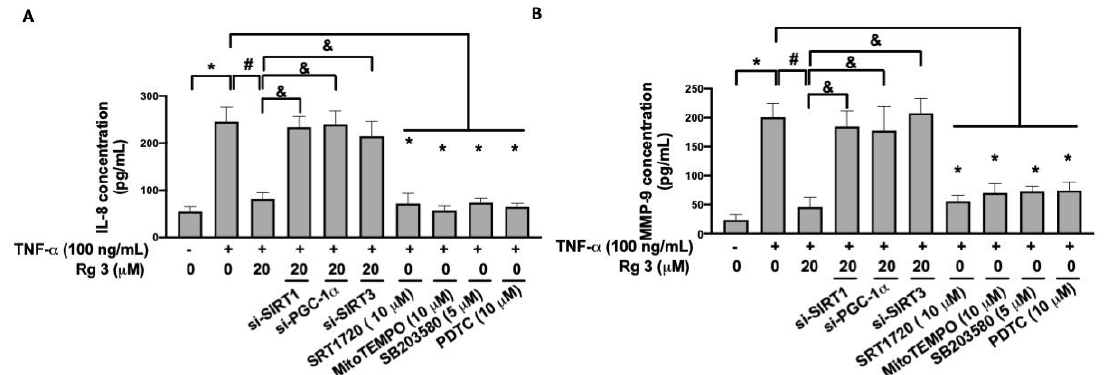
Figure 6. Rg3 reduces TNF- α -caused pro-inflammatory response and MMP-9 activation in human chondrocytes through SIRT1/PGC-1/SIRT3/NF-kB pathway. Chondrocytes were stimulated to 100 ng/mL TNF- α for 24 h were shown. The selective activator SIRT1, SRT1720, and the inhibitor of mitochondrial ROS, mitoTEMPO, the inhibitor of MAPK p38, S203580, and the inhibitor of NF- α B, PDTC, were pre-treated 2 h before TNF- α stimulation. The culture medium was collected for IL-8 ( A ) and MMP-9 ( B ) ELISA assay. (* indicating p < 0.05 compared with the control group; # indicating p < 0.05 compared to TNF- α -stimulated cells; & indicating p < 0.05 compared to TNF- α plus Rg3